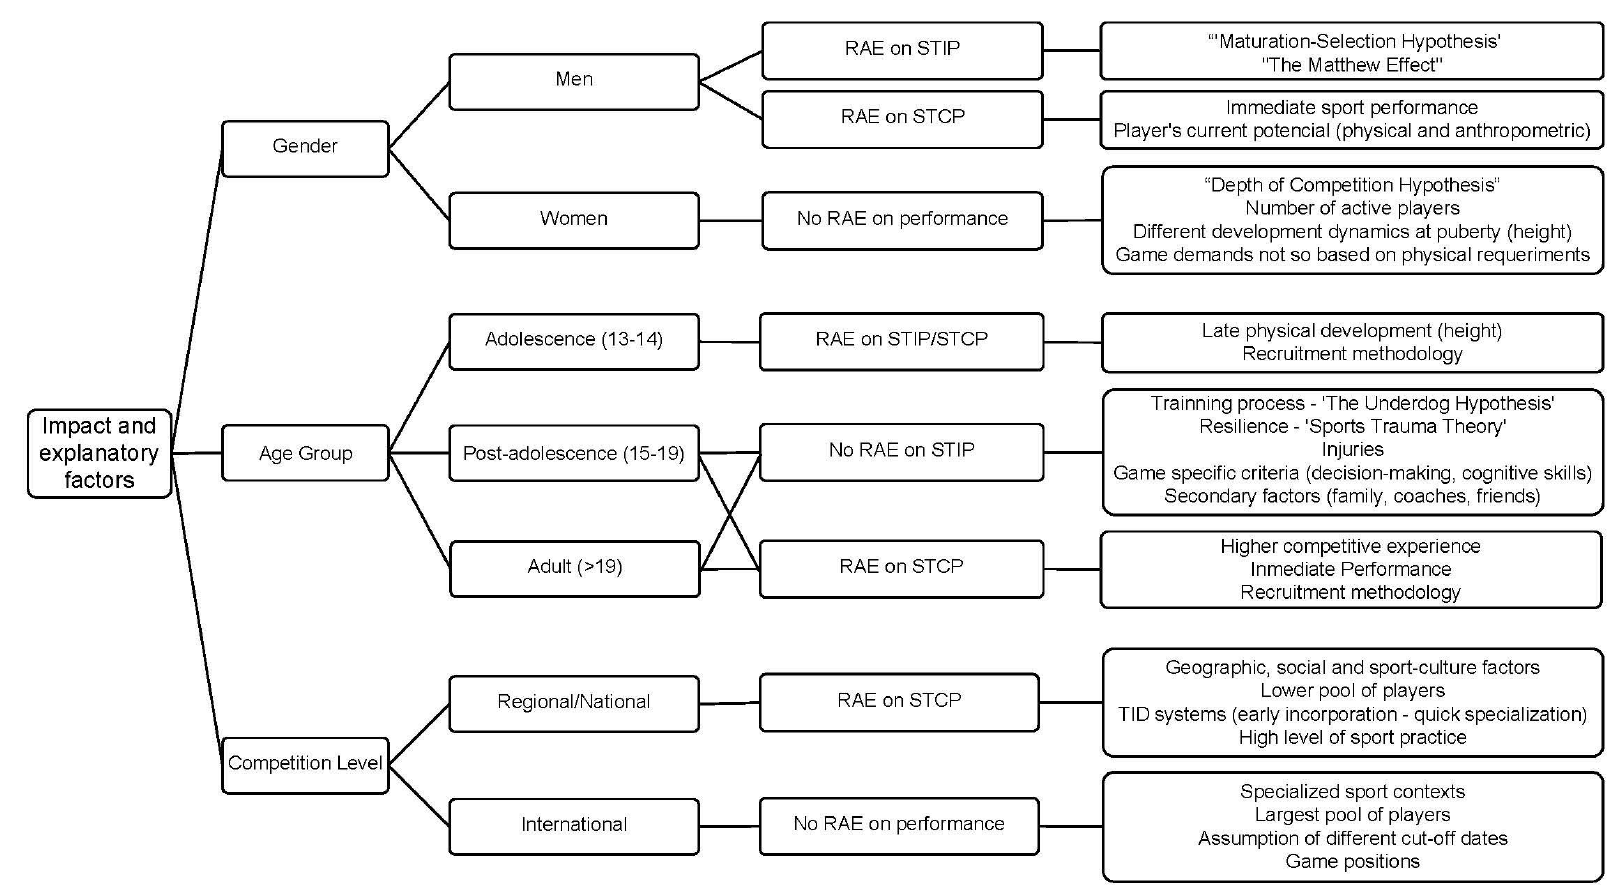
Figure 2. Summary of impact and explanatory factors of the impact/non-impact of the relative age effect (RAE) on competition performance in basketball. Notes: “RAE” = relative age effect; “STIP” = short - term individual performance; “STCP” = short - term collective performance; “TID” = talent identification and development.